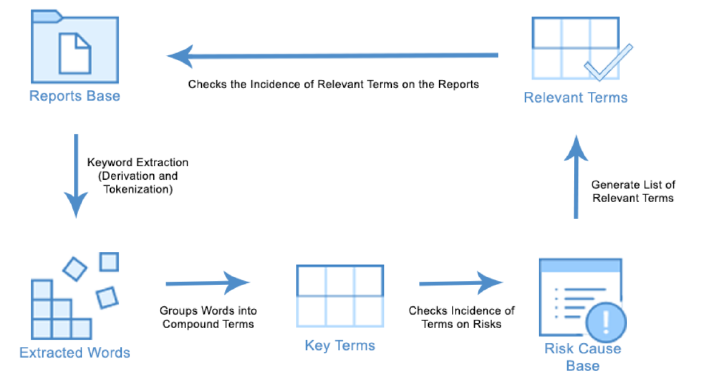
Figure 2. Diagram representing the risk keyword